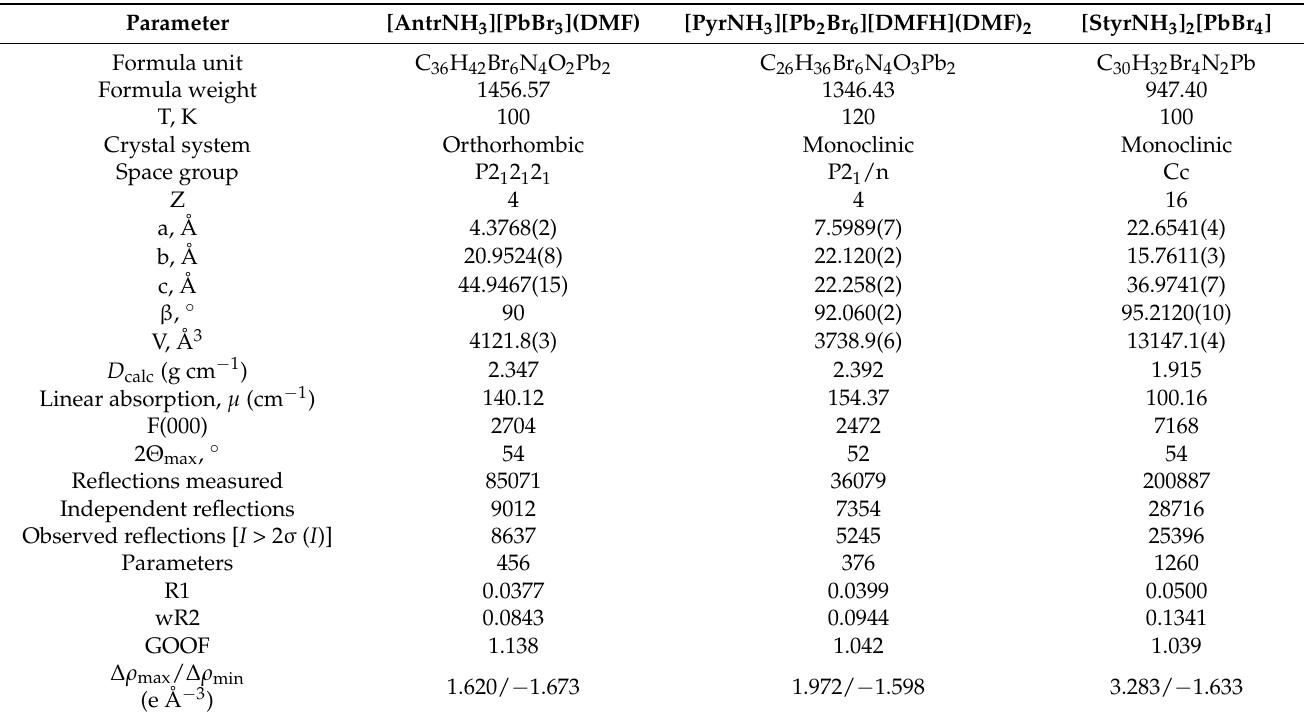
Table 1. Crystal data and structure refinement parameters for [AntrNH 3 ][PbBr 3 ](DMF), [PyrNH 3 ][Pb 2 Br 6 ][DMFH](DMF) 2 and [StyrNH 3 ] 2 [PbBr 4